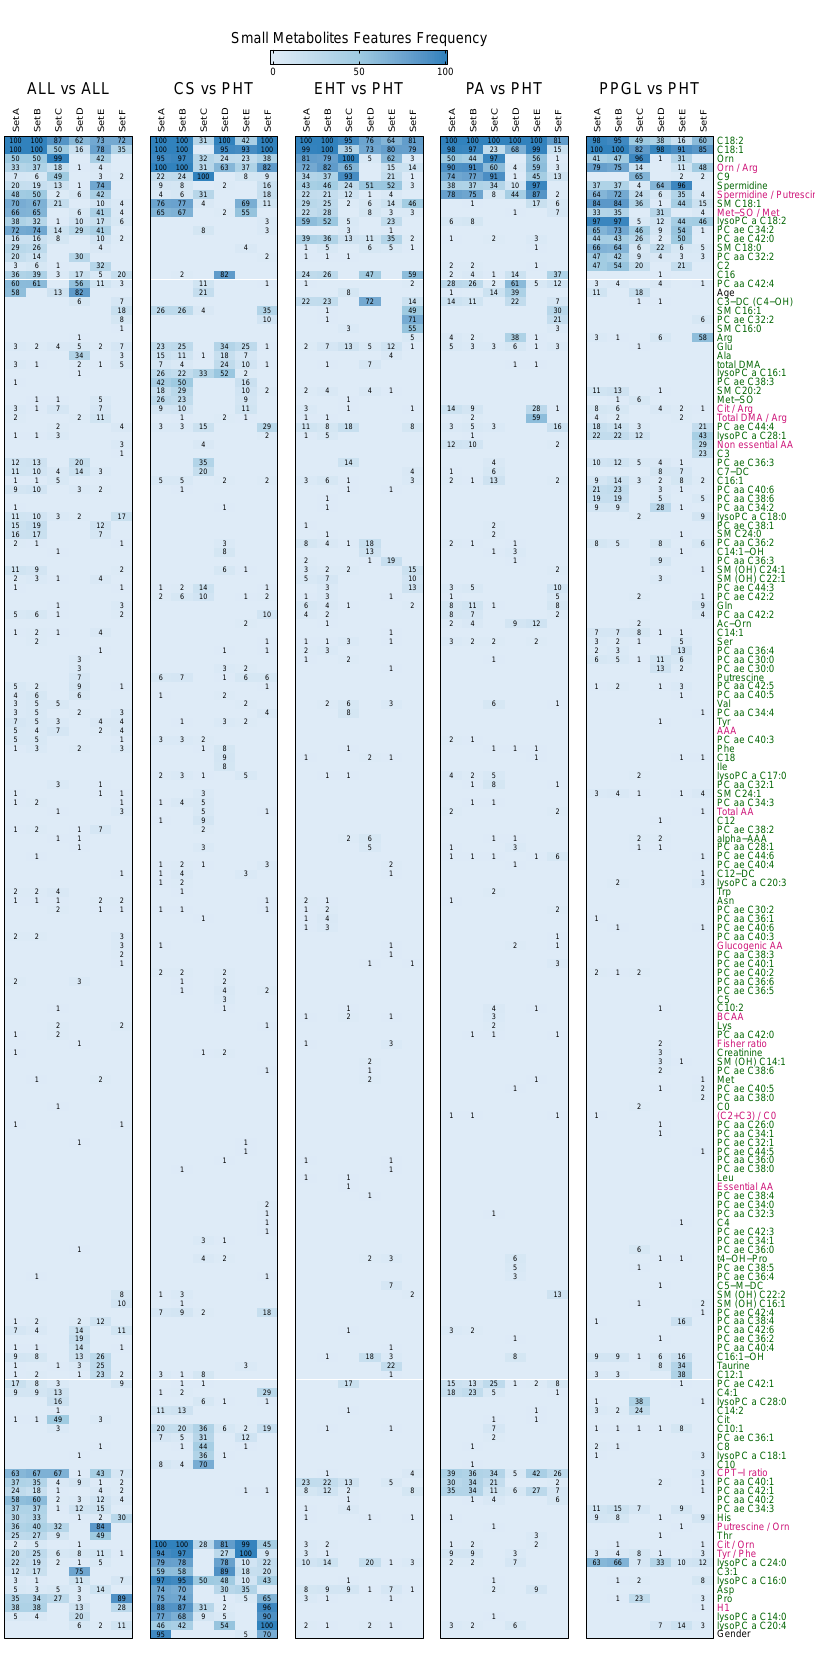
Figure A1. Combined heatmap showing the number of times featured for Sets A–F, showing all metabolites (in green) and metabolite ratios (in pink) selected for all 5 disease